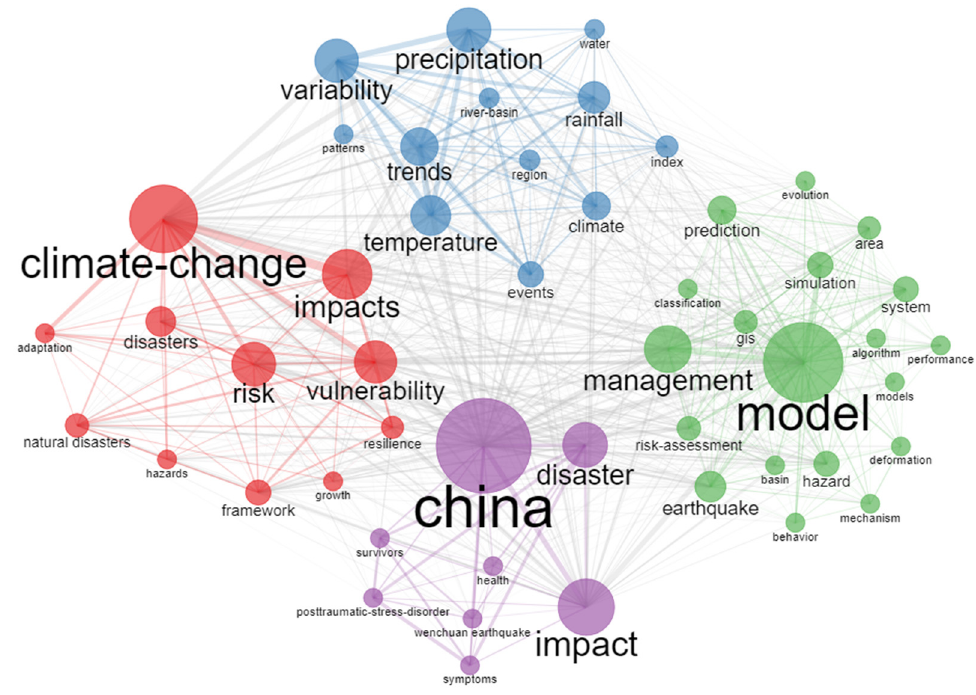
Figure 3. Main topics of disaster research in China from 2011 to 2020 (Data source: Web of Science, Access date: 14 October 2021).